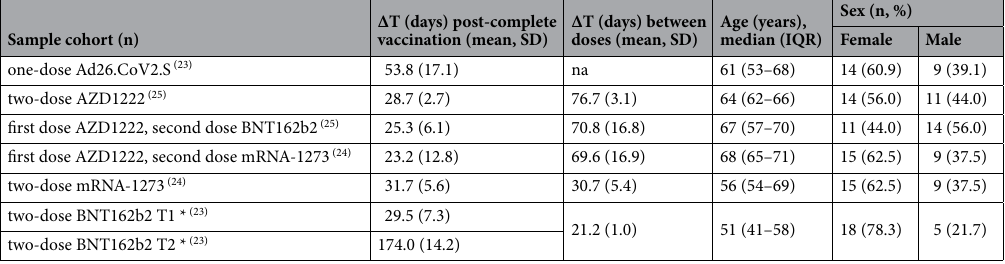
Table 1. Sample characteristics. na. not applicable. *Two-dose BNT162b2 T1 and two-dose BNT162b2 T2 are paired longitudinal